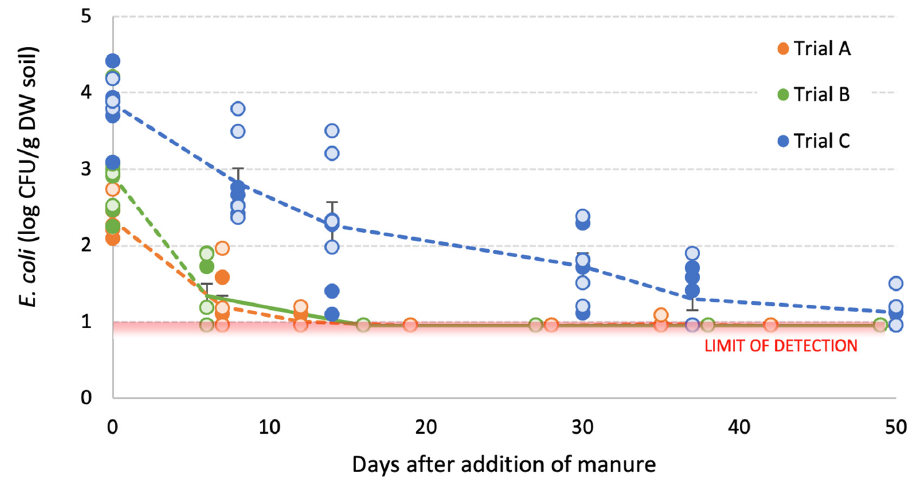
Figure 2. Populations of E. coli in sandy ( • ) and clay loam ( ) soil amended with cow manure inoculated with E. coli and L. innocua . Each point represents a test result (4 points/sampling time/soil type/trial) and is expressed per gram dry weight (g DW) of soil. Dashed lines indicate the mean for each dataset; bars indicate the standard error of mean values.